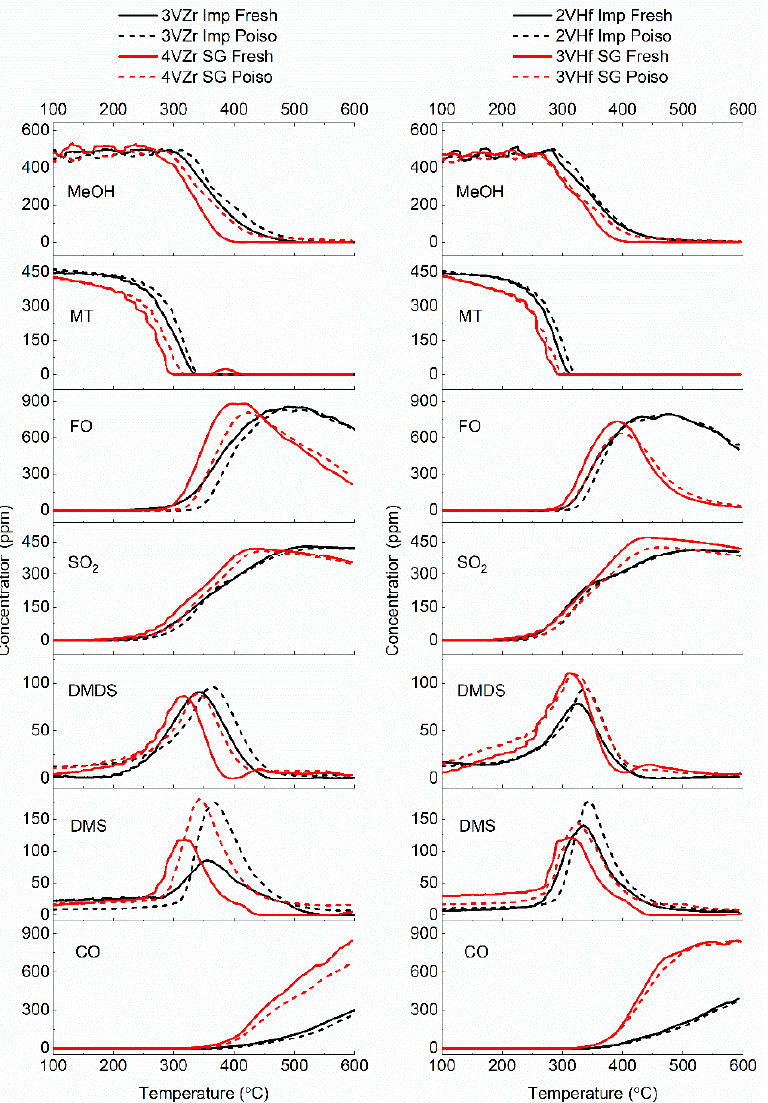
Figure 6. Comparison of fresh and poisoned catalysts; consumption of reactants and formation of different reaction products.